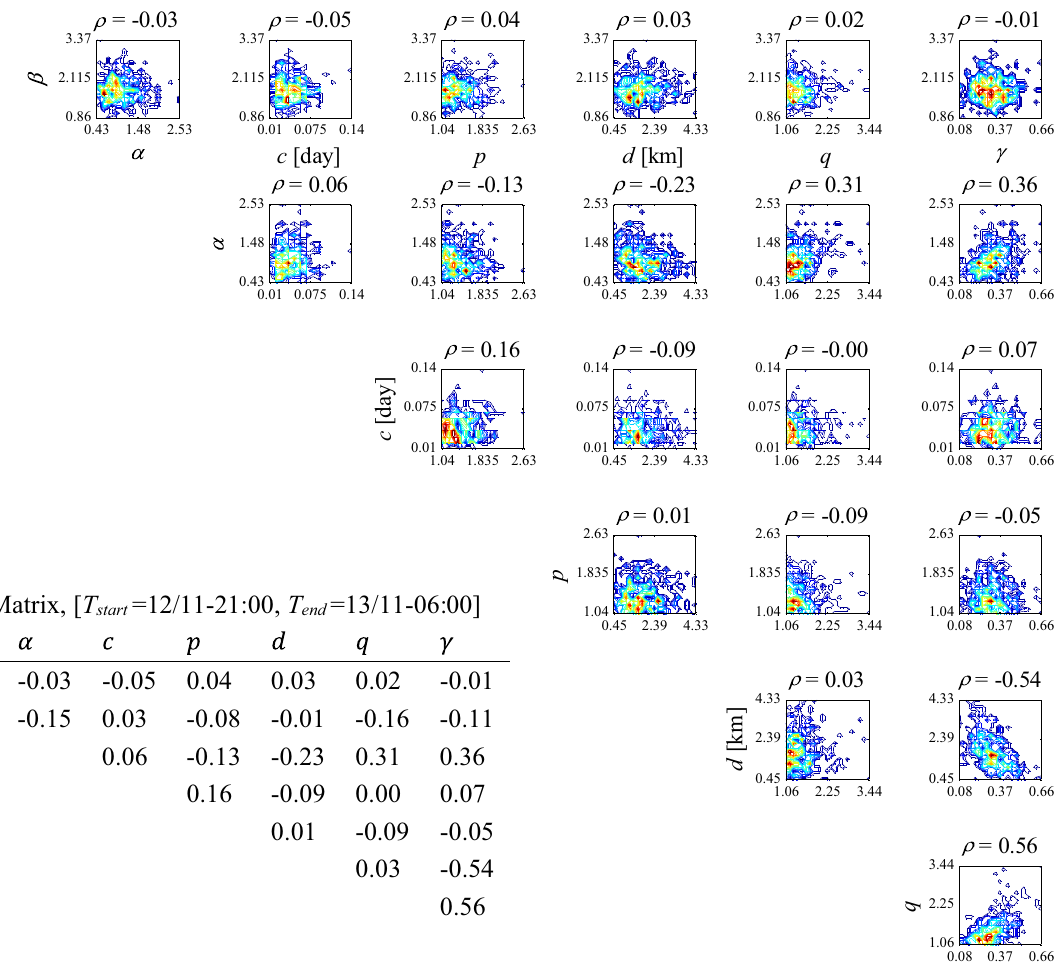
Figure 4. Contour lines representing the correlation between pairs of the posterior marginal samples of θ = [ β , α , c , p , d , q , γ ] for the first forecasting interval (1st row in Table 1) and the corresponding correlation